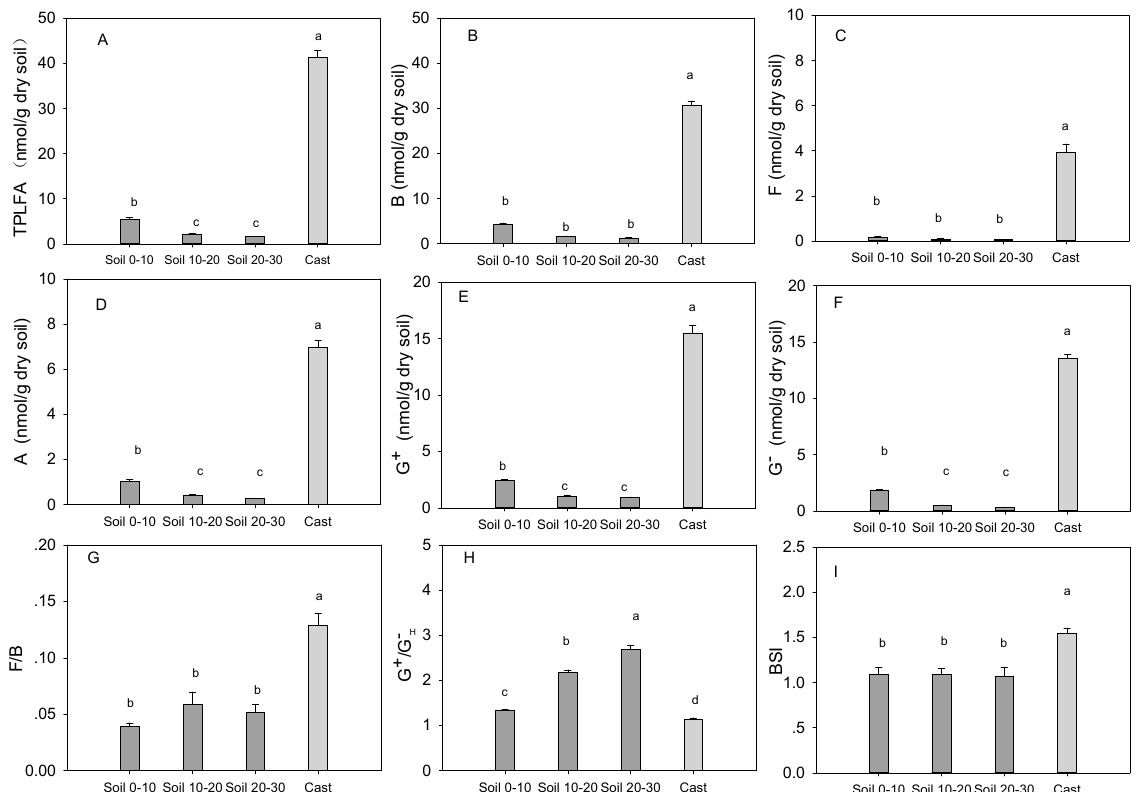
Figure 3. The microbial biomass and community structure in surface earthworm casts and bulk soils. ( A ) TPLFA, total phospholipid fatty acids which represented total microbial biomass; ( B ) B, bacterial biomass; ( C ) F, fungal biomass; ( D ) A, actinomycete biomass; ( E ) G + , Gram-positive bacterial biomass; ( F ) G − , Gram-negative bacterial biomass; ( G ) F/B; ( H ) G + /G − ; ( I ) BSI, bacterial stress index. Samples were collected in May 2016. Data are shown as means ± SE, n = 5. Bars with different letters differed significantly.